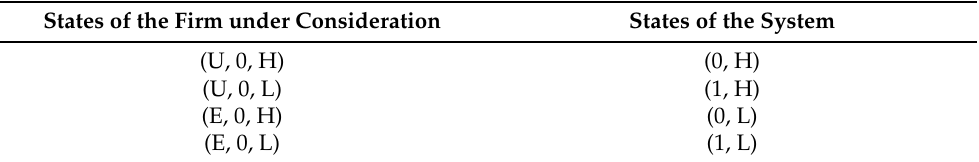
Table 1. States of the firm under consideration and states of the system with one active firm. States of the Firm under